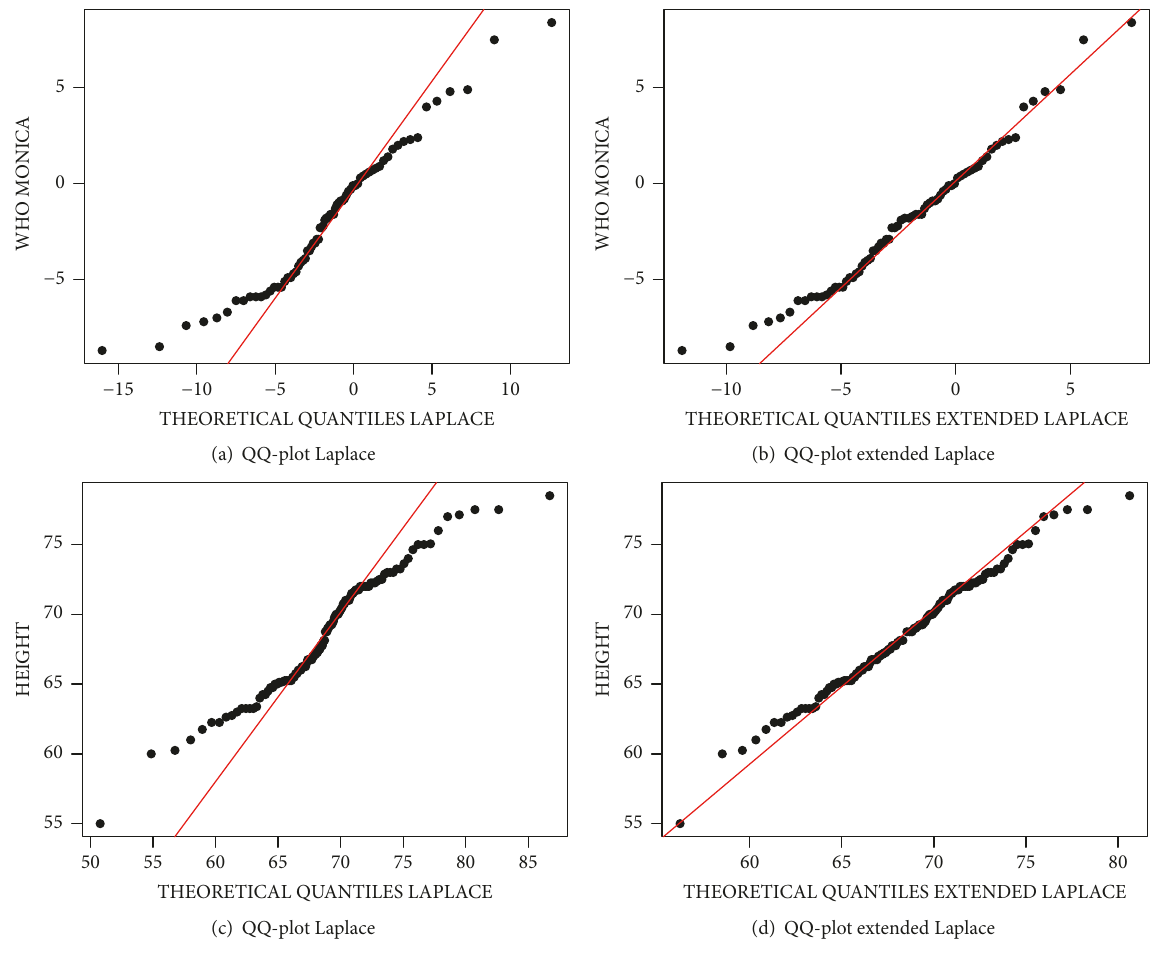
Figure 3: QQ-plot for the WHO MONICA and HEIGHT data